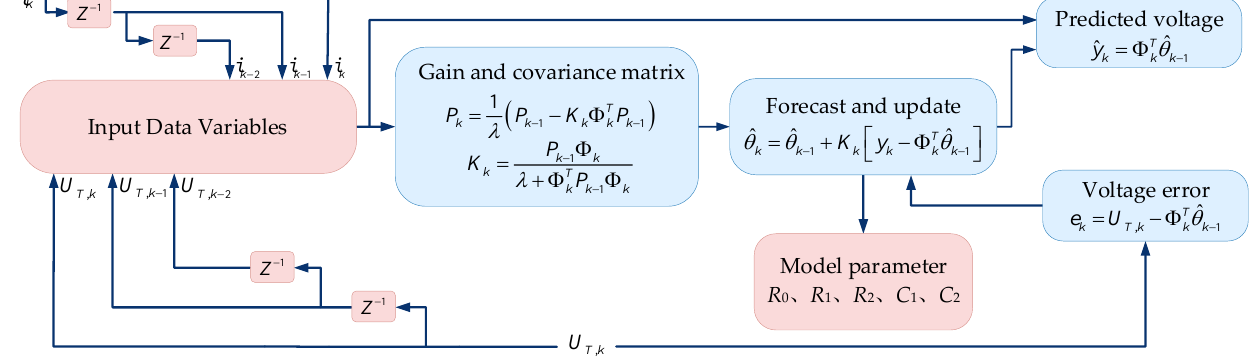
Figure 3. Schematic diagram of forgetting factor recursive least squares (FFRLS).